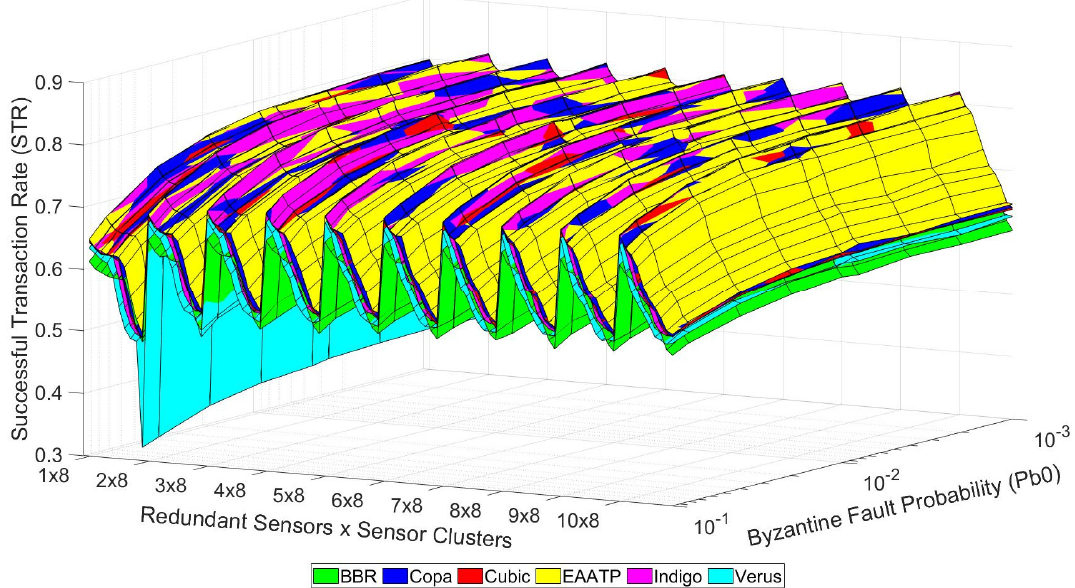
Figure 10. Trustworthiness mesh (standard mode).